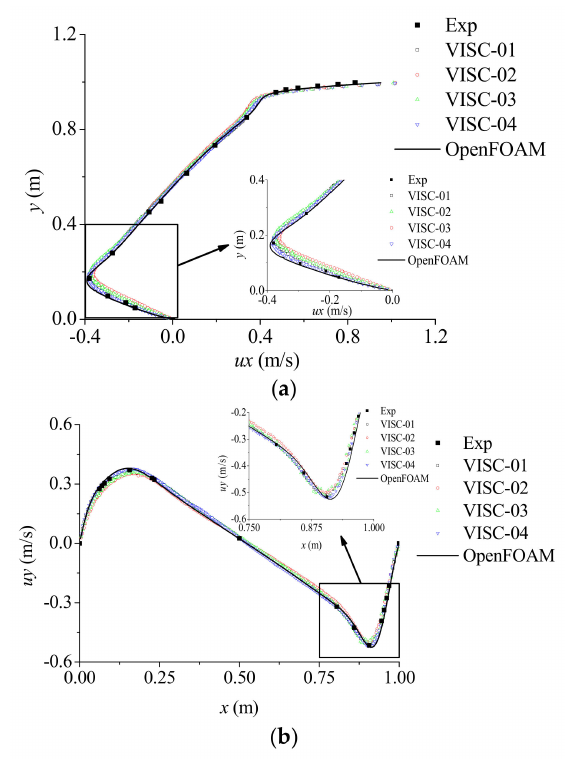
Figure 9. Comparisons of four viscosity force models for the lid-driven flow: ( a ) ux velocity distribution; and ( b ) uy velocity distribution. OpenFOAM, Open source Field Operation and Manipulation; Exp, Experimental data of Ghia et al.